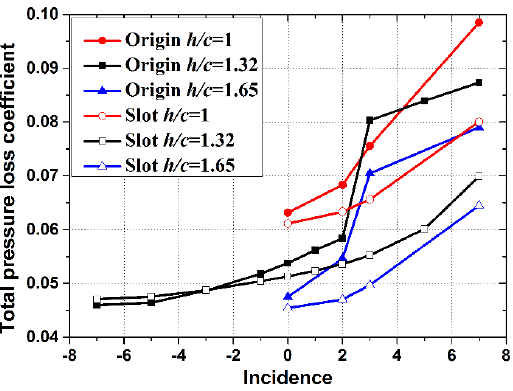
Figure 8. Influence of the aspect ratio for different incidence angles on the total pressure loss coefficient with and without the slot configuration.